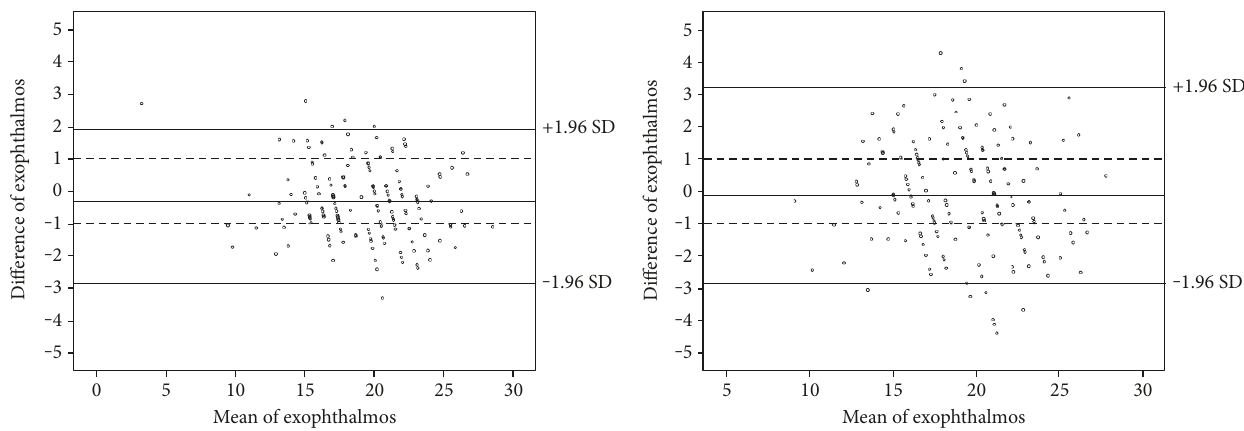
Figure 3: Bland-Altman plots compared the results of Hertel exophthalmometer and CT measurement. The left one showed the di ff erence between the Hertel results and the coordinate x of EC , and the right one showed the di ff erence between the Hertel results and 2D CT E exophthalmos. It could be found that the di ff erence between the Hertel results and 2D CT exophthalmos was more dispersed than that between the Hertel results and x and had much fewer plots within − 1~1 mm. E